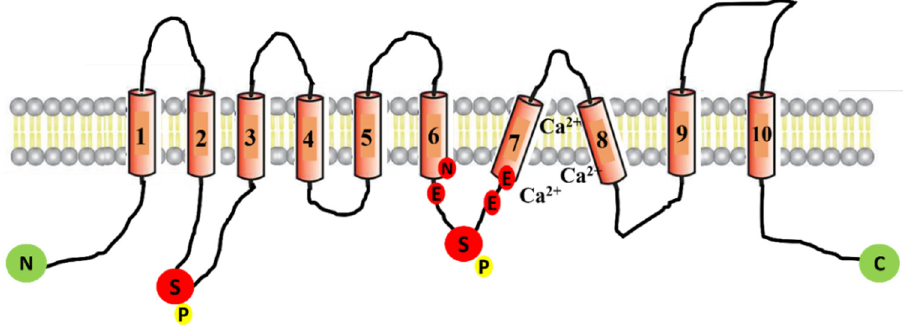
Figure 1. Schematic representation of ANO1 channel protein. The ANO1 channel protein consists of 10 transmembrane domains (TMD). The intracellular loop between TMD-7 and TMD-8 contains six amino acids (N650, E654, E702, E705, E734, and D738) that participate in forming the calcium-binding pockets of the channel. The depicted location of two phosphorylation sites (serine 471 and serine 673) is denoted with the letter